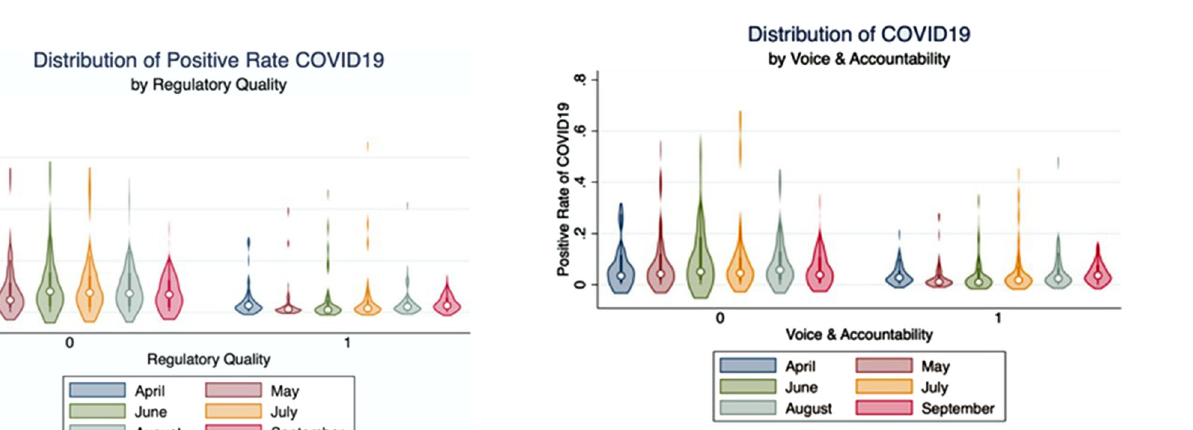
Fig. 11 Distribution of the COVID-19 positive rate by voice and